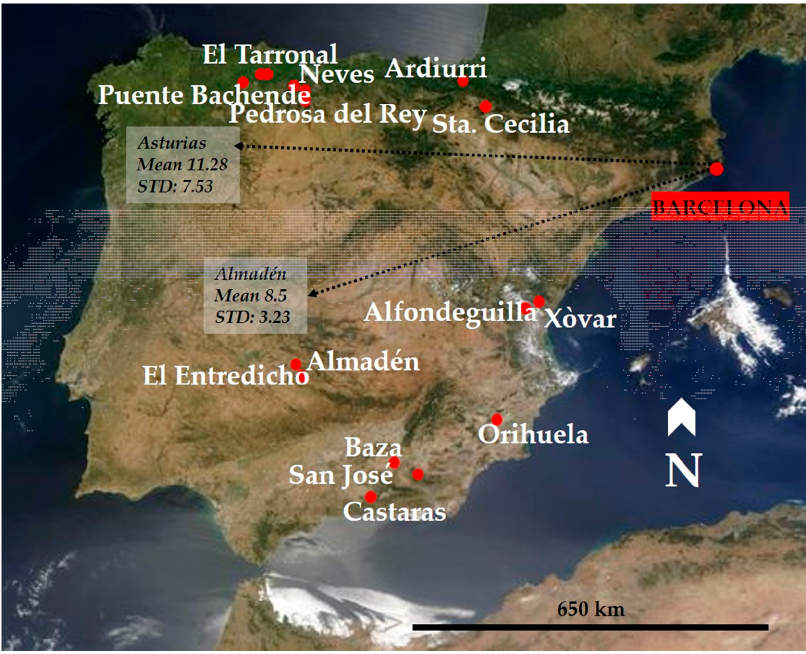
Figure 5. Indication of the possible provenance areas on the map with all the sampled mines.